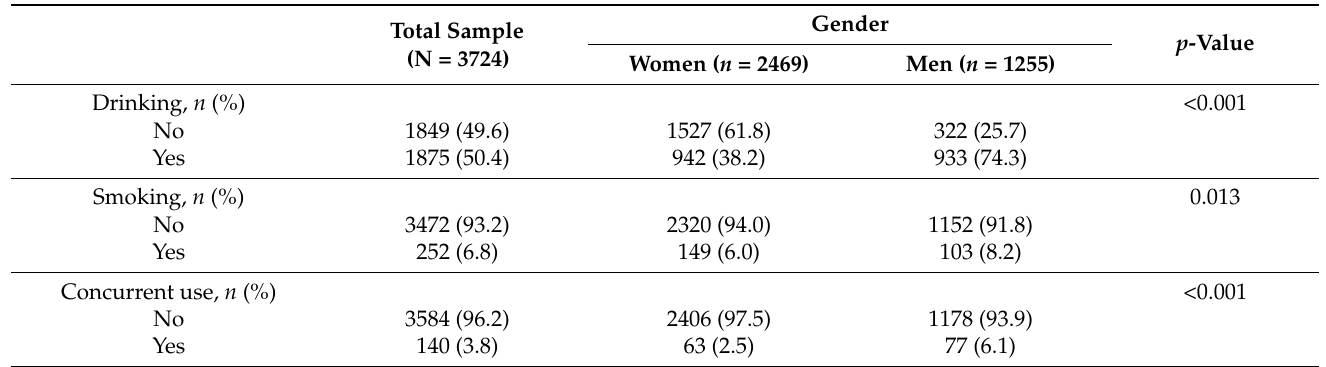
Table 2. Substance use at baseline for the total sample and by gender.